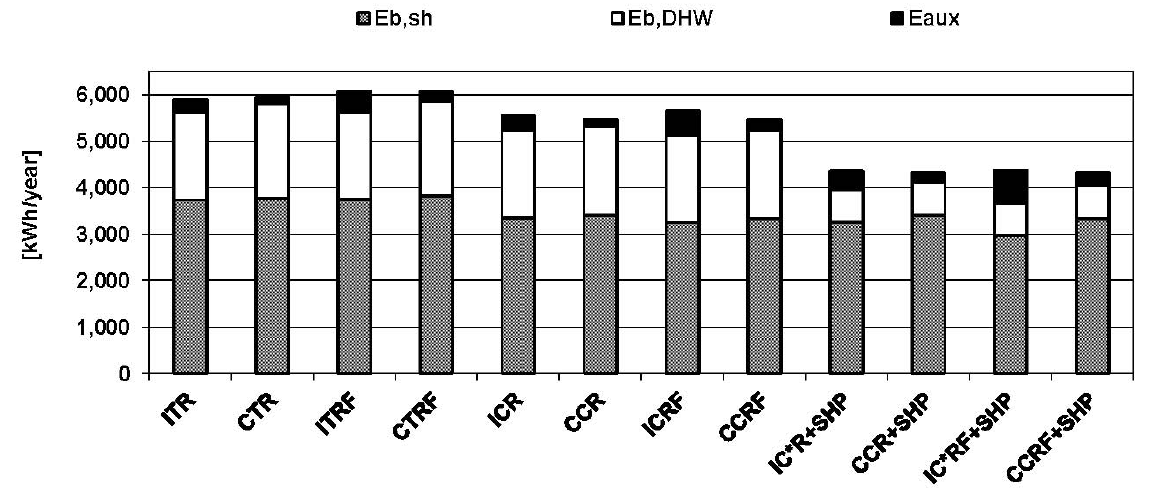
Figure 8. Primary energy needs of heating